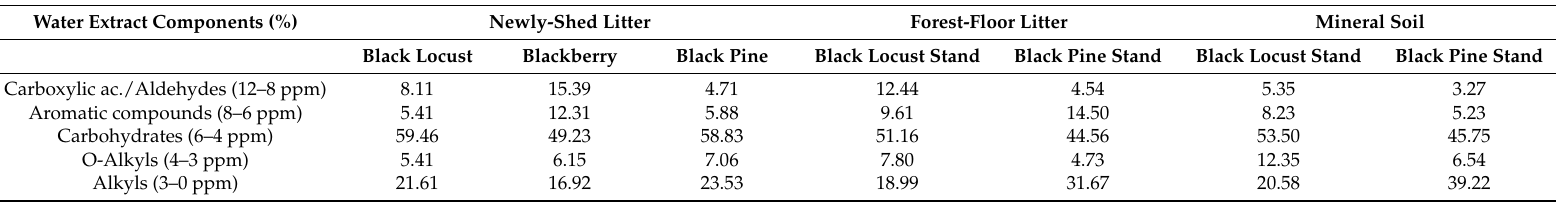
Table 3. Water extract components of newly-shed and forest-floor litter and mineral soil from two paired forest stands at Mount Vesuvius. .